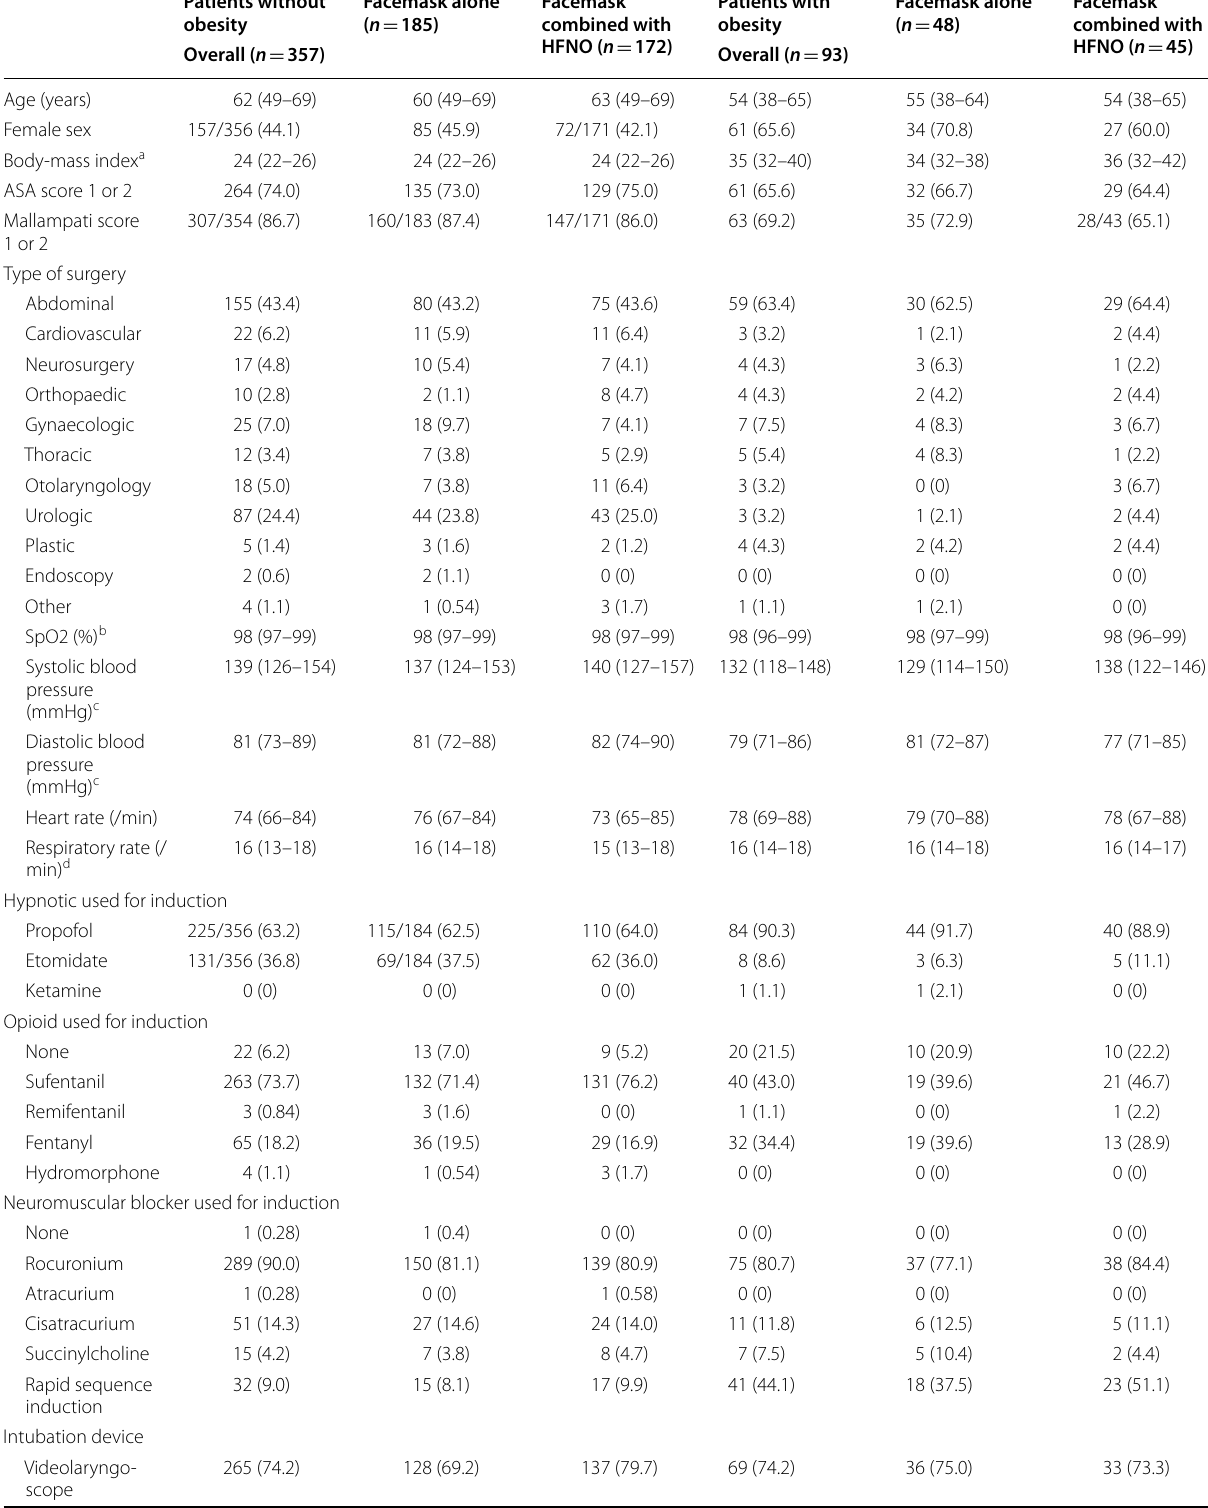
Table 3 Baseline characteristics according to obesity